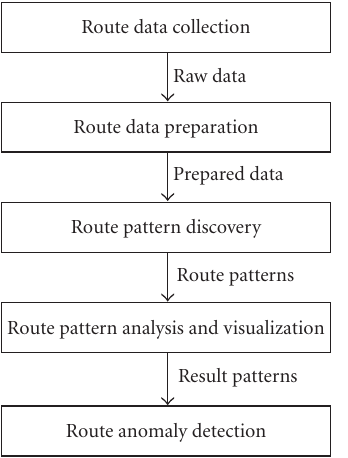
Figure 2: The five steps used by the proposed system.